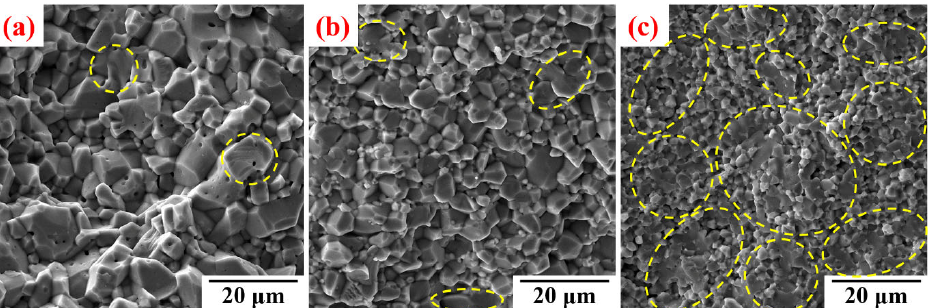
Fig. 11 SEM micrographs of the fracture surfaces of (a) Sample AL, (b) Sample MM, and (c) Sample CP. The transgranular fractures are marked with yellow circles.